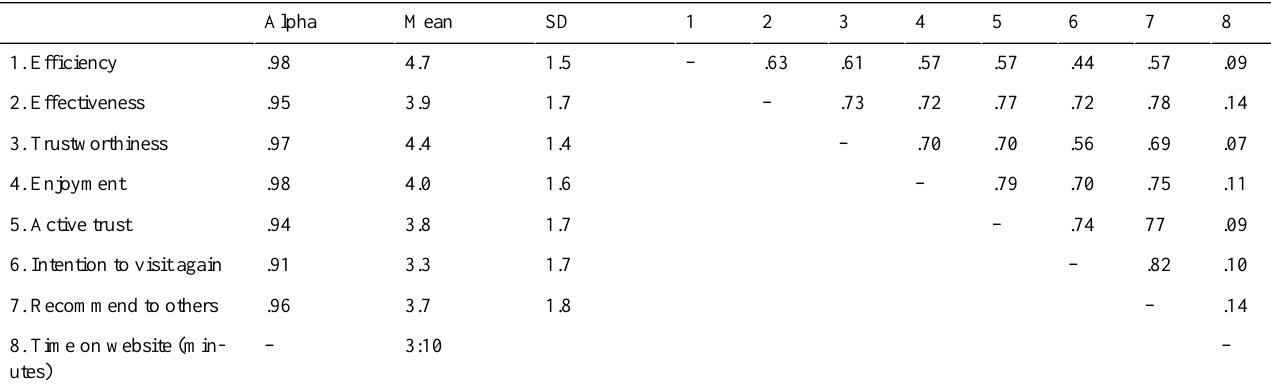
Table 3. Correlation matrix intervention 3 (N =